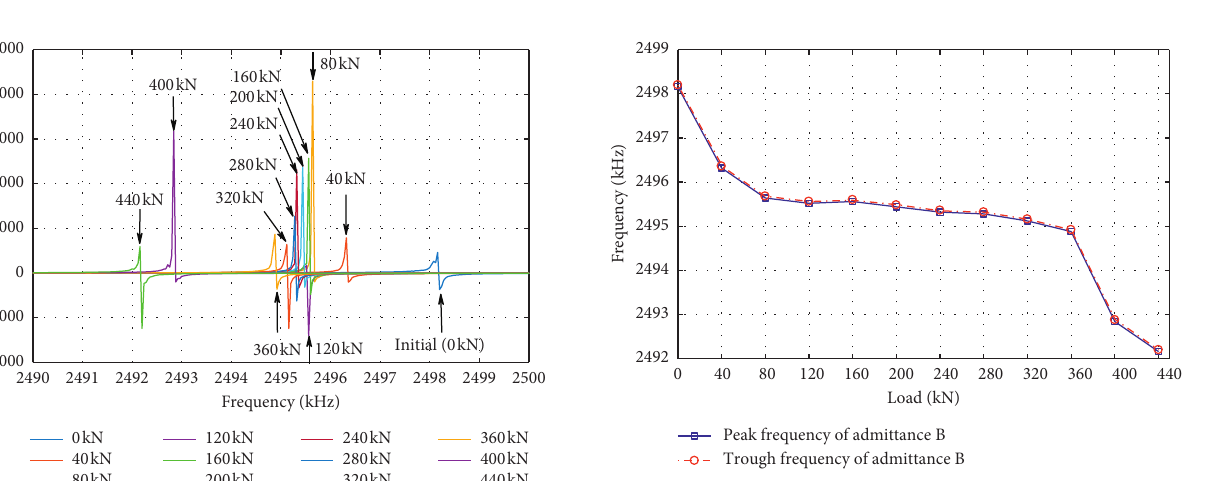
Figure 15: Frequencies of the peak and trough in the admittance signature for column